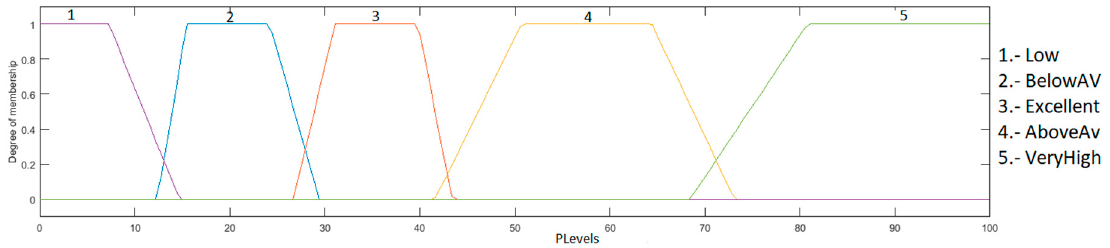
Figure 6. Output heart rate level.